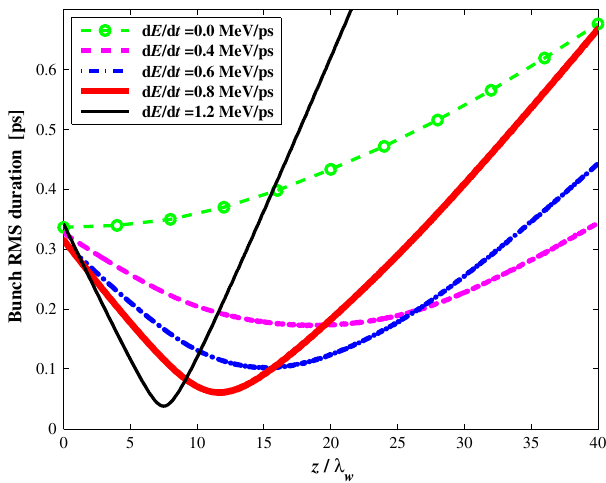
FIG. 2. Evolution of bunch RMS duration along the trajectory in the ECSE FEL. The bunch charge Q b ¼ 30 pC, and the bunch duration f s T b ≈ 1 . Random Gauss initial distribution of N q ¼ 300 charged particles.